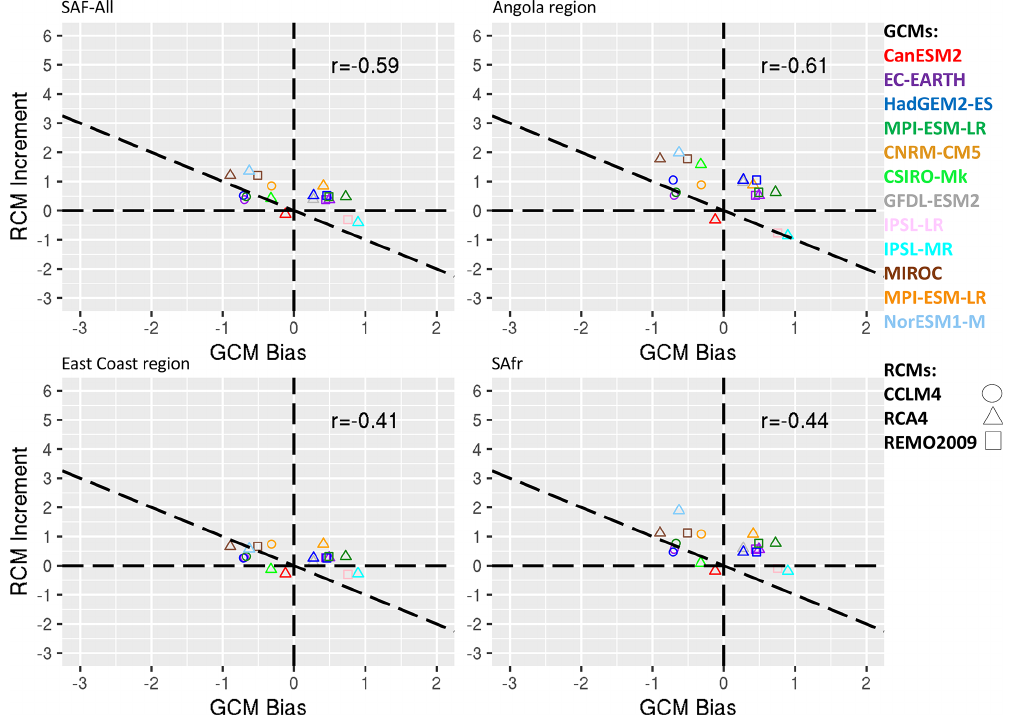
Figure 7. Scatterplots of the RCM increment (RCM − GCM) for precipitation (mmd − 1 ) as a function of the GCM bias (GCM-OBS) for October. Colours indicate the driving GCM, and shapes indicate the downscaling RCMs. The four panels indicate spatial averages over southern Africa (SAF-All region), the Angola region, the East Coast region, and the SAfr region,